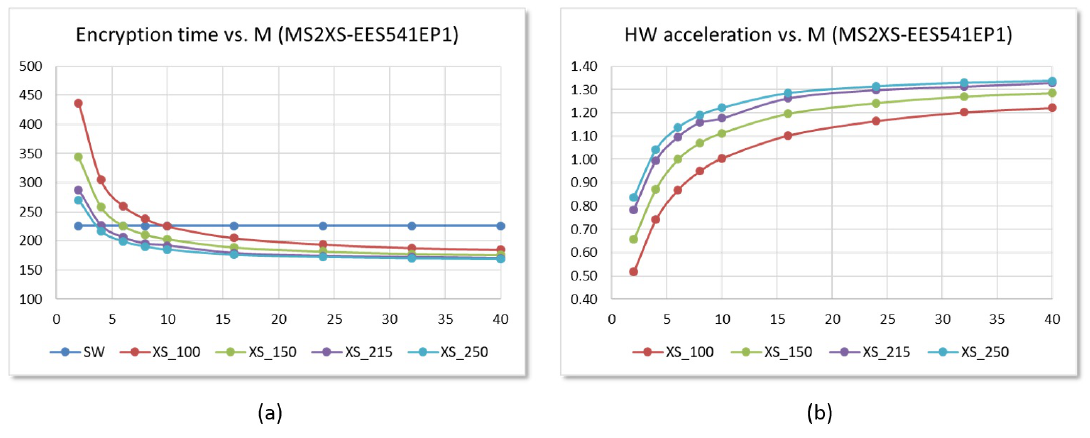
Figure 22. Evolution versus number of arithmetic units of the time invested ( a ) and the acceleration factor reached ( b ) in the encryption operation using the set of parameters EES541EP1 for SW and HW/SW embedded systems implemented on the Ultra-96 board using AXI4-Stream IPs (time displayed in µ